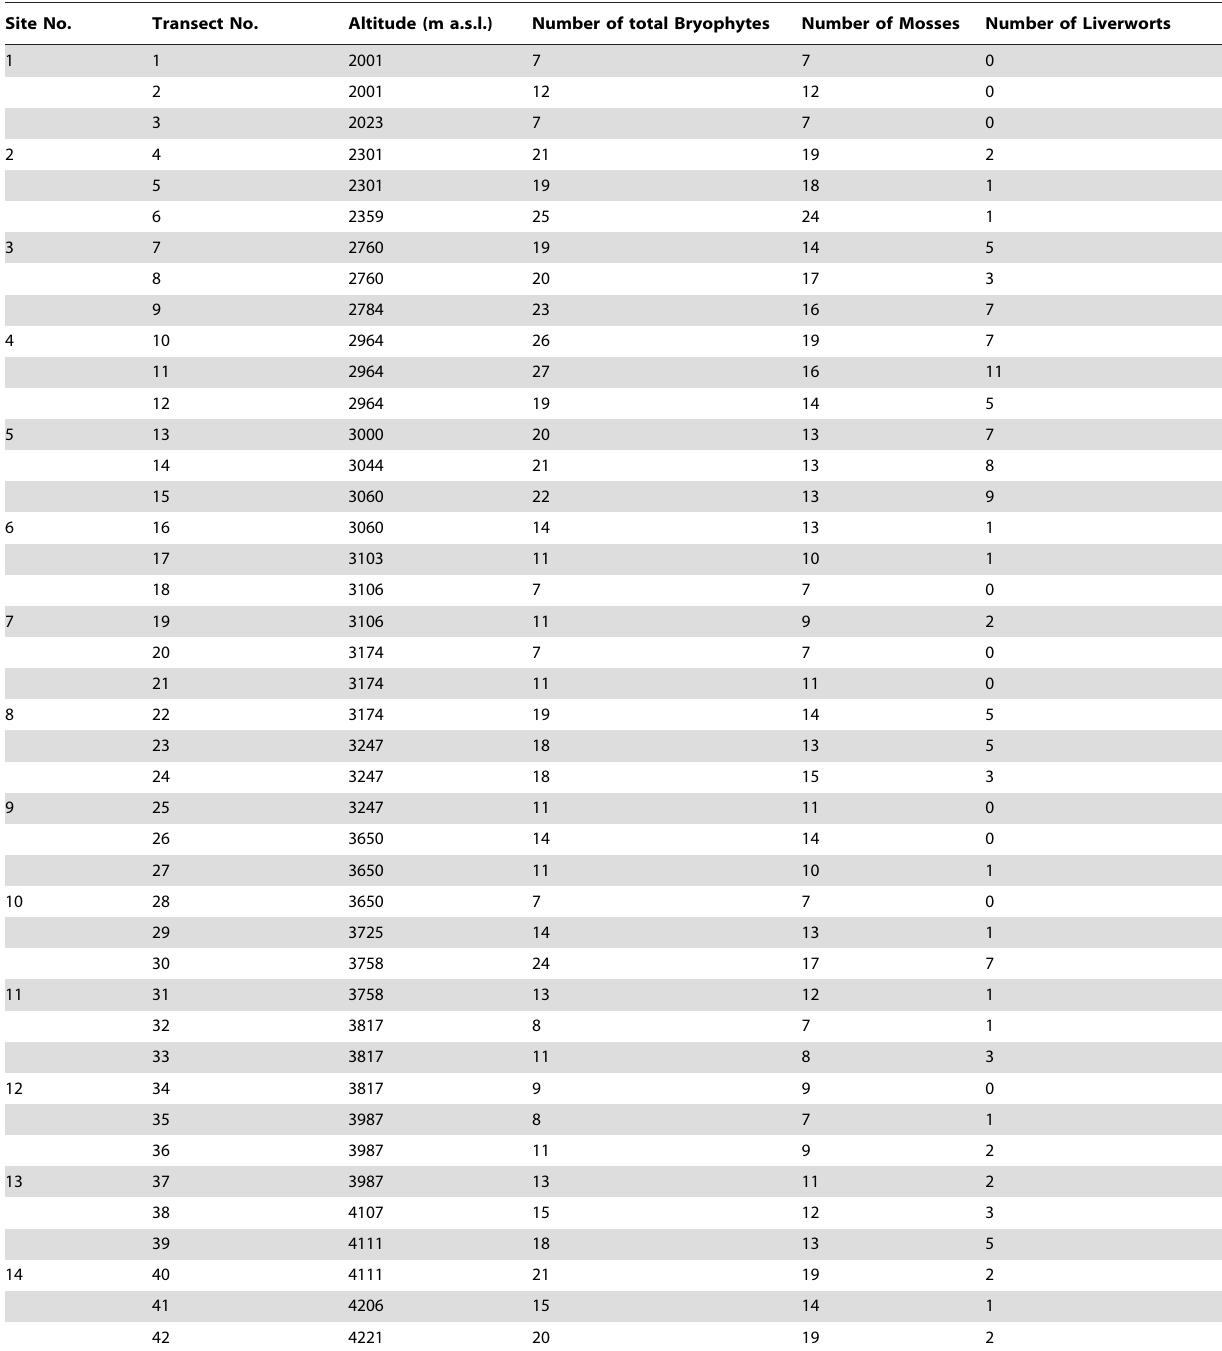
Site No. Transect